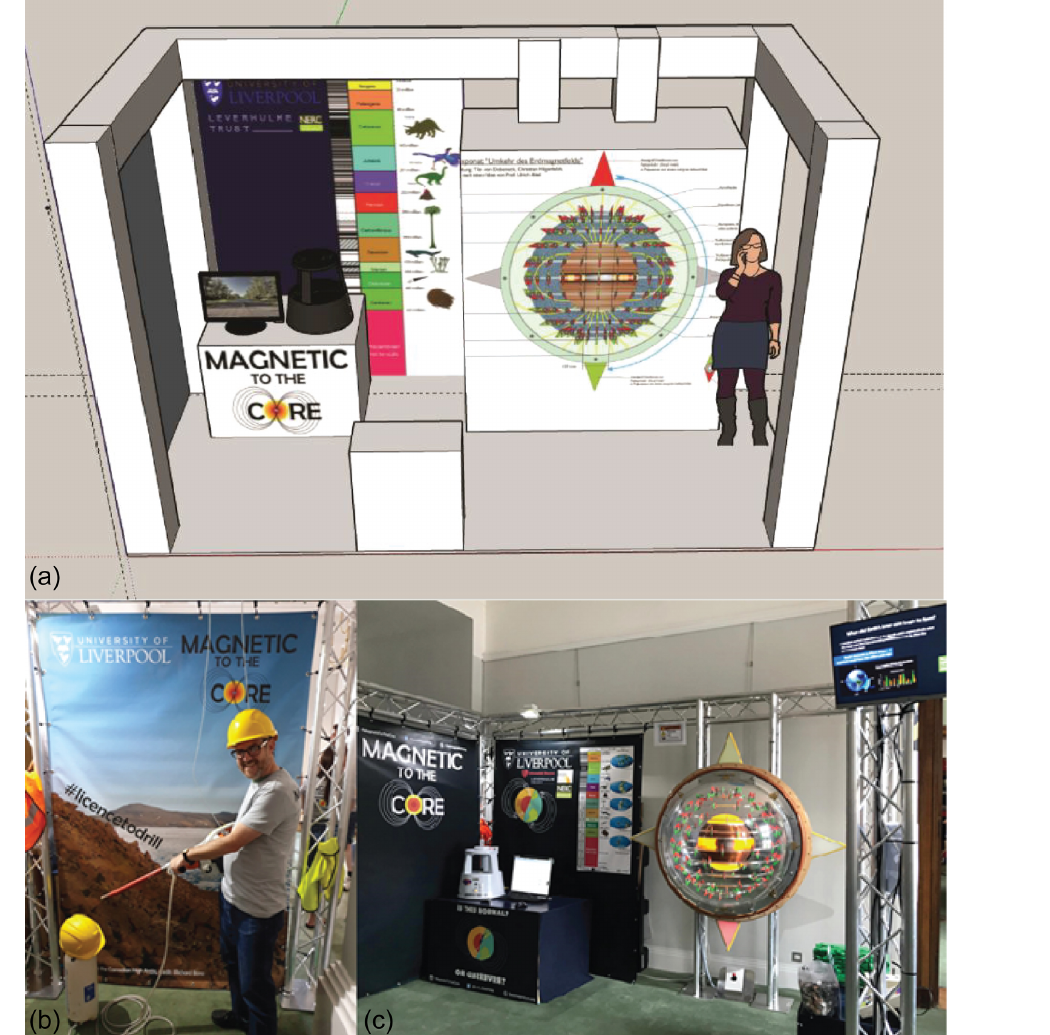
Figure 1. (a) Preliminary design of the stand in SketchUp; the size of the entire stand is 4m × 2m. (b) Andy Biggin receiving his license to drill. (c) The Magnetic to the Core stand at the Royal Society Summer Science Exhibition, 2019. On the left is the kickstool magnetometer, in the centre is the magnetic globe, and rock or choc is on the right. The license to drill is on the far left of this image, behind the Magnetic to the Core